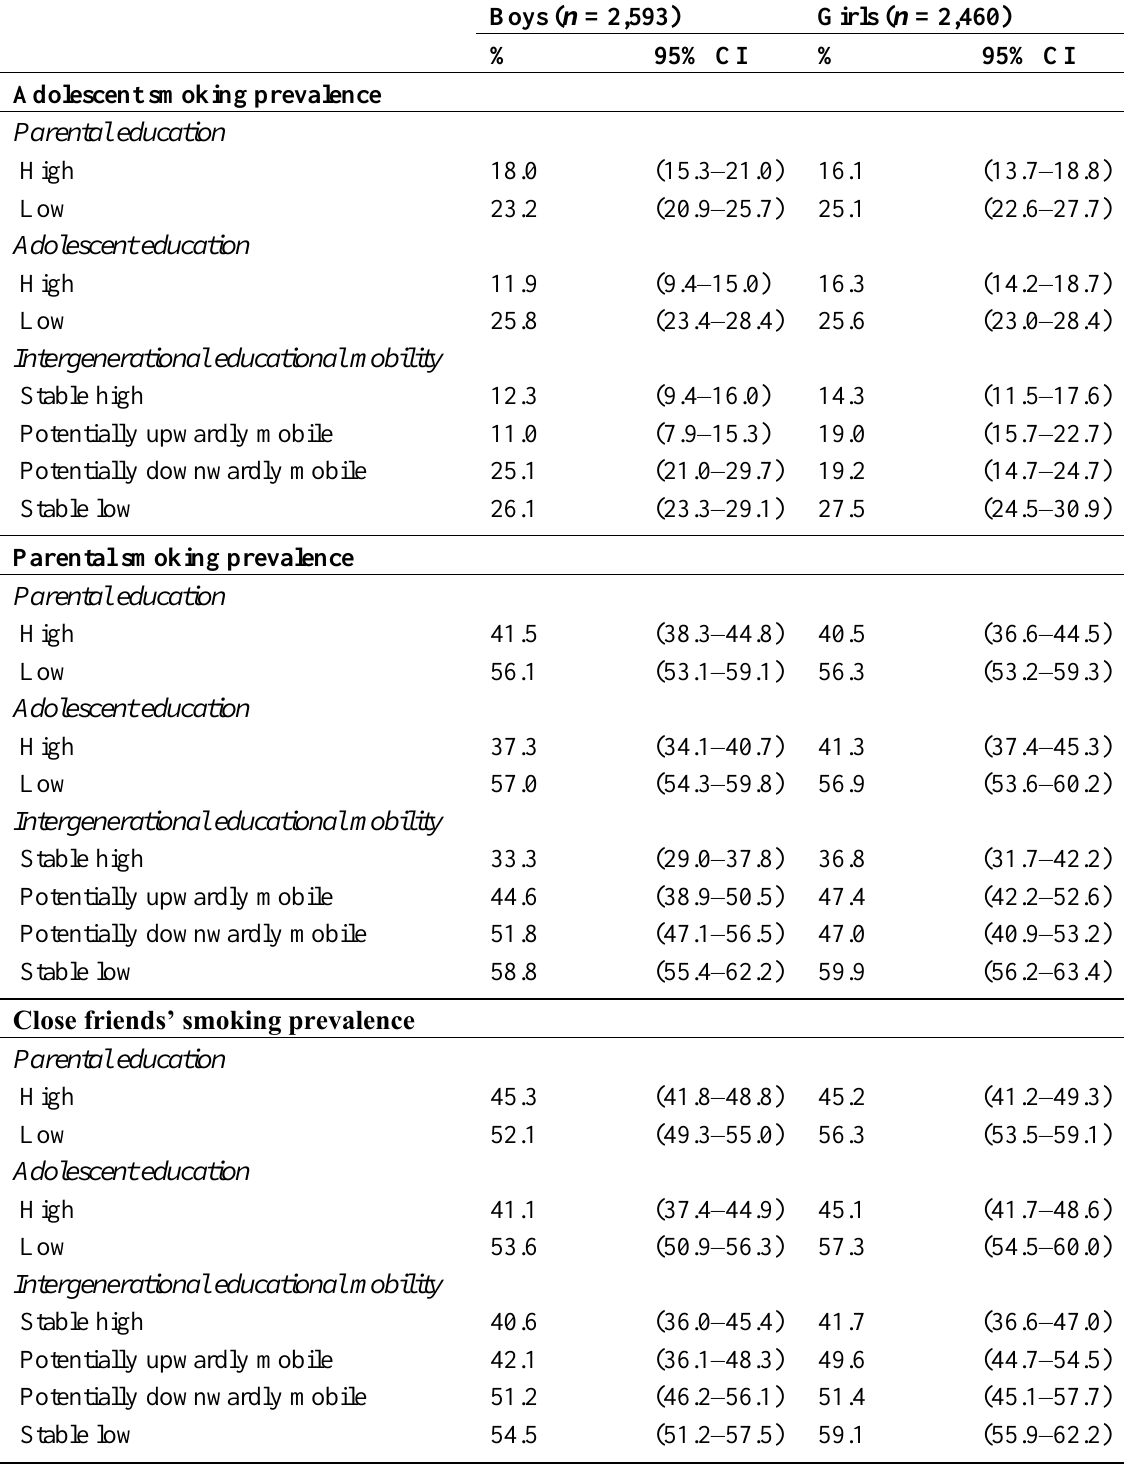
Table 2. Adolescent, parental and close friends’ smoking prevalence by education levels and intergenerational educational